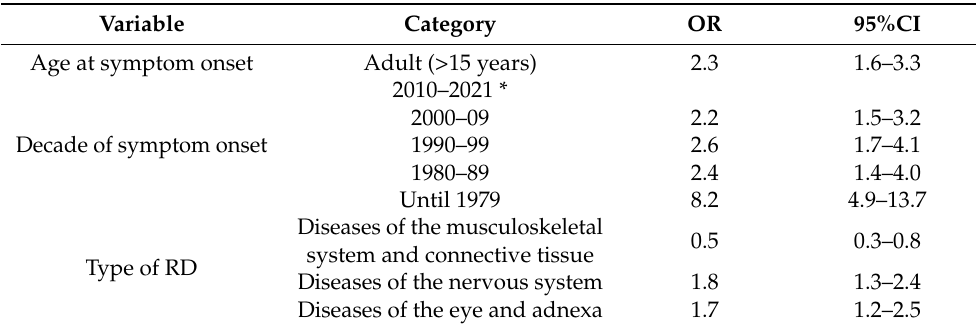
Table 2. Determinants associated with taking more than 6 months to attend the first medical visit from time of RD symptom onset.